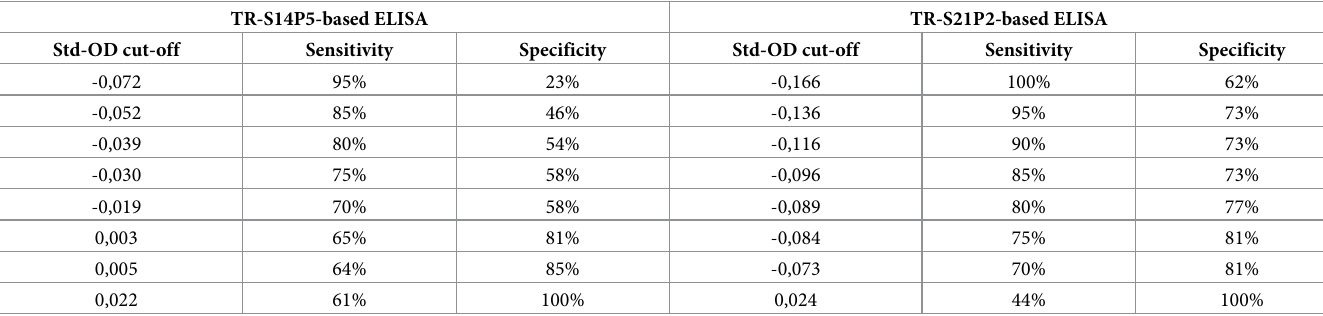
Table 1. Diagnostic sensitivity and specificity of TR-S14P5- and TR-S21P2-based ELISA at different standardized-OD cut-offs. TR-S14P5-based